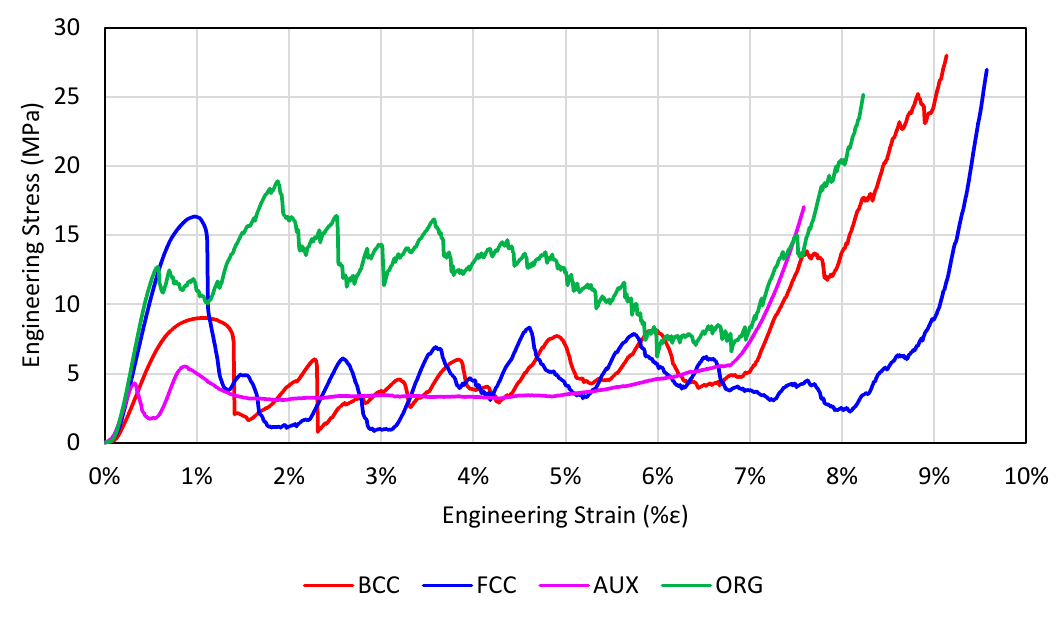
Figure 10 . Stress–strain curve calculated for the four lattice topologies from the compression test results.